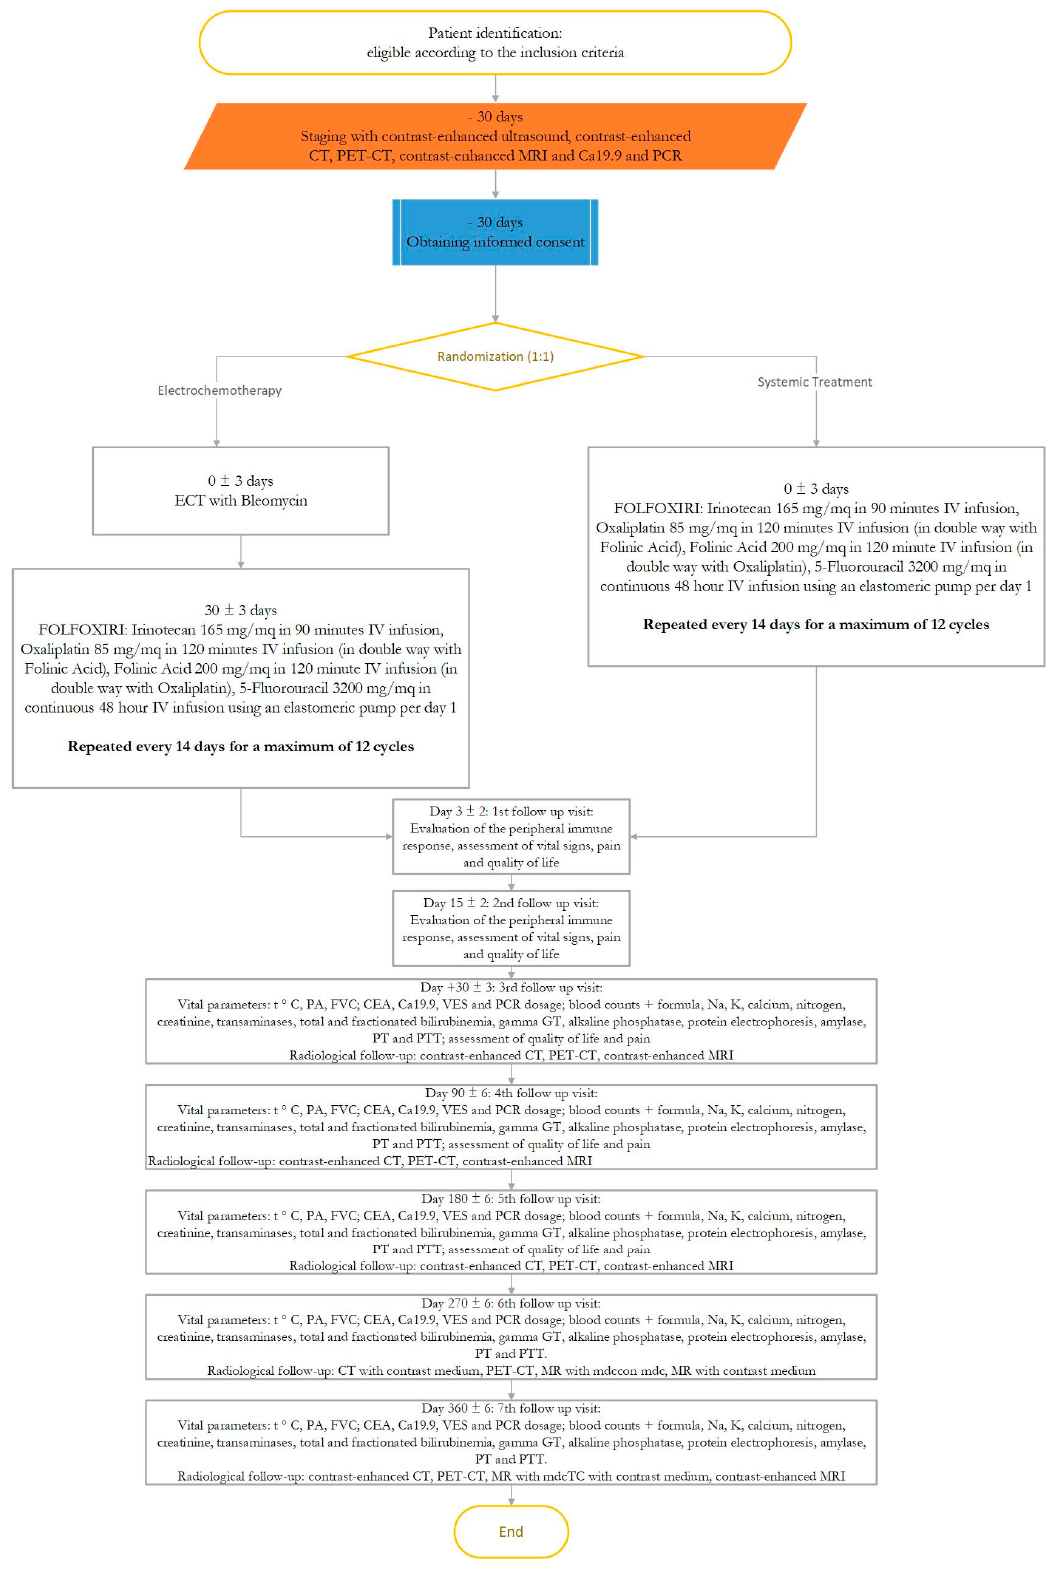
Figure 1. Trial design flowchart.